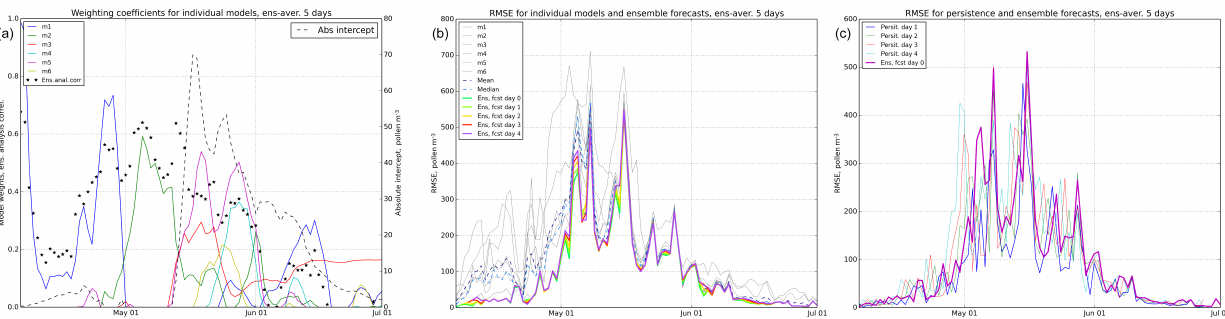
Figure 11. Optimal weights of the individual models and ensemble correlation score over the 5-day-long assimilation window (panel a ); RMSE of the of individual models and the optimal ensemble forecasts against those of individual models and simple ensemble means (b) , and against persistence-based forecasts (panel c